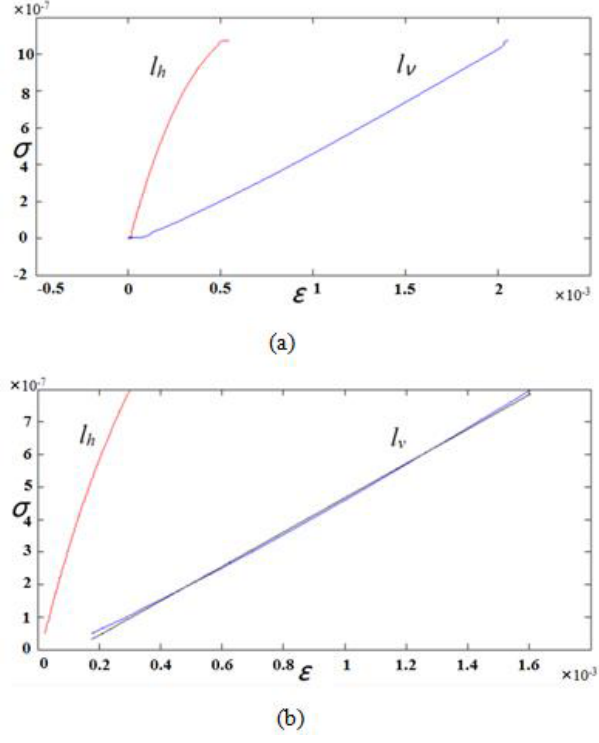
Figure 10. Calculation curve of the mechanical parameters of the